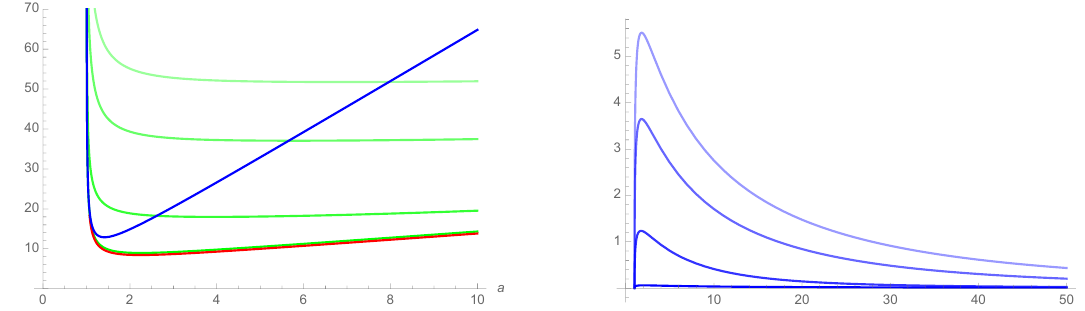
Figure 3 . (Left:) Plot of ^ k (red), ^ k 0 (blue), and ^ k s (green, y 1 2 f 0 ; 20 ; 100 ; 200 g ) as given in eqs. (F.20) and (F.23) as functions of the penalty factor a , with (cid:15) = 10 (cid:0) 10 . Clearly, (cid:22) k represents a shorter geodesic than the straight-line circuit with (cid:22) k 0 . This again indicates the existence of short- cuts outside of the normal-mode subspace in the penalized geometry. For (cid:22) k s , the opacity re(cid:13)ects the value of y 1 , with y 1 = 0 the lowest/darkest curve running parallel to ^ k and y 1 = 200 the (cid:0) (cid:22) (cid:1) highest/faintest. (Right:) Plot of k s (cid:0) (cid:22) k = (cid:22) k as a function of a for (cid:15) = 10 (cid:0) 10 , where the shading runs through the same range of y 1 as in the left plot (from y 1 = 0 at the bottom to y 1 = 200 at the top). Though it is not clear at this scale, the lower-most curve, y 1 = 0, follows the same basic shape as the others, peaking at a (cid:24) 0 : 1 and then slowly approaching to zero as a ! 1 . The curves never become negative, indicating that (cid:22) k s > (cid:22) k for all a > 1.